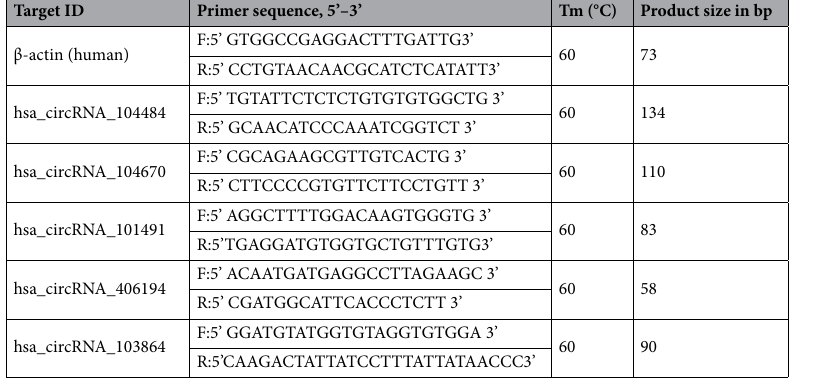
Table 2. Primers designed for qRT-PCR analysis of